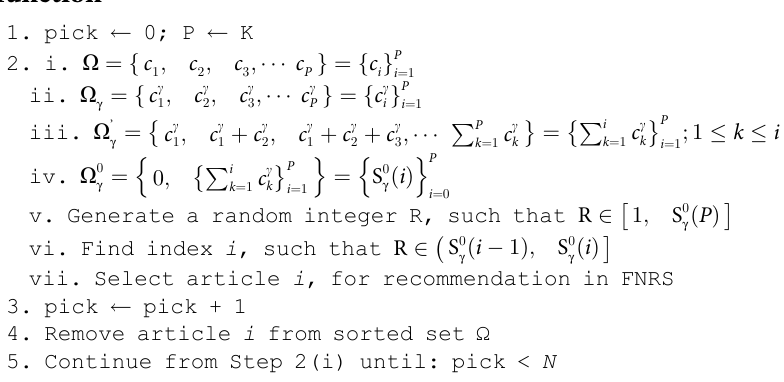
Algorithm 1. Selection of articles for recommendation using